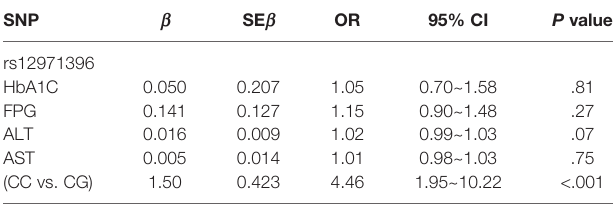
TABLE 2 | Hardy – Weinberg equilibrium test and allelic frequencies. TABLE 4 | Binary logistic regression analysis of dyslipidemia and genotype.